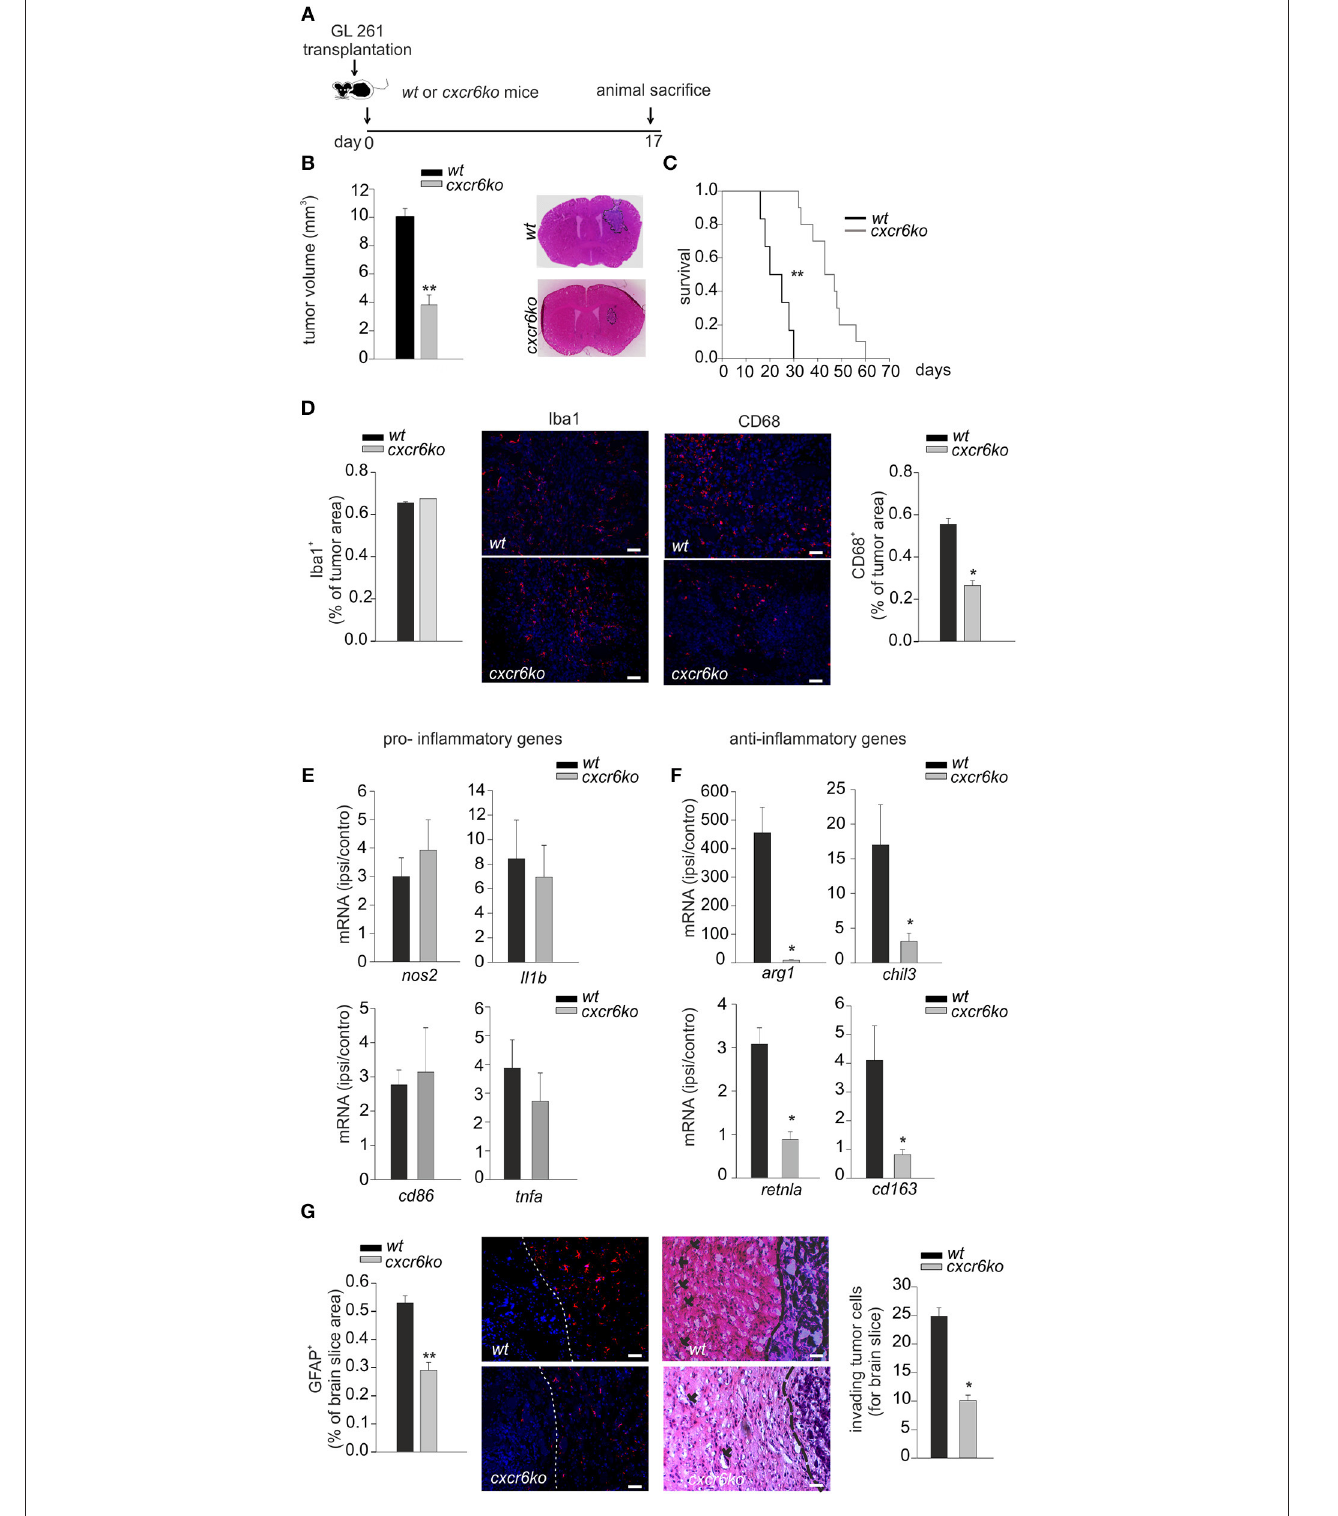
FIGURE 3 | CXCL16/CXCR6 axis is involved in establishing a pro-tumor microenvironment. (A) Representative scheme of GL261 transplantation in wt and cxcr6ko mice; (B) bar histogram of the mean ( ± s.e.m.) of tumor volume in wt and cxcr6ko mice, and representative hematoxylin-eosin stained coronal brain sections of